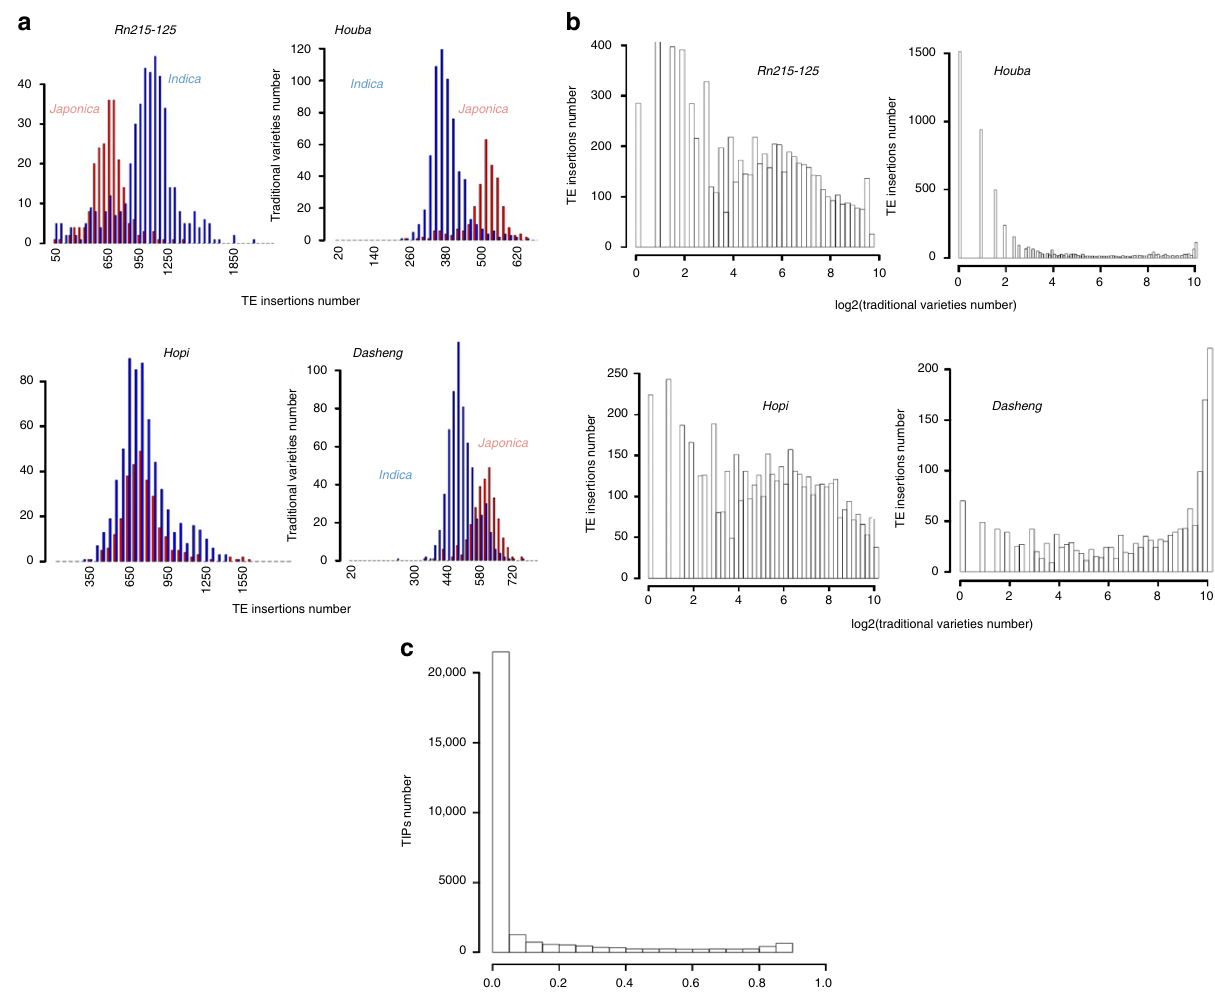
Fig. 2 History of TE families. a Distribution of the number of TE insertions in traditional varieties. x axis represents the number of TE insertions for each TE family. Indica and Japonica varieties are shown in blue and red, respectively. b Distribution of traditional varieties by TE insertion. The x axis represents the number of rice traditional varieties in log2 scale and y axis the number of TE insertions. For all the TE families, the peak on the left corresponds to TE insertions present at very low frequencies in rice varieties, which suggests recent insertions. c Distribution of frequencies of TIPs in traditional varieties. x axis shows the frequency of TE insertion in traditional varieties and y axis shows the frequencies for all TE insertion in all 32 families. Most TIPs are present with low frequencies (<0.01), i.e., TE insertions are only in one or two rice